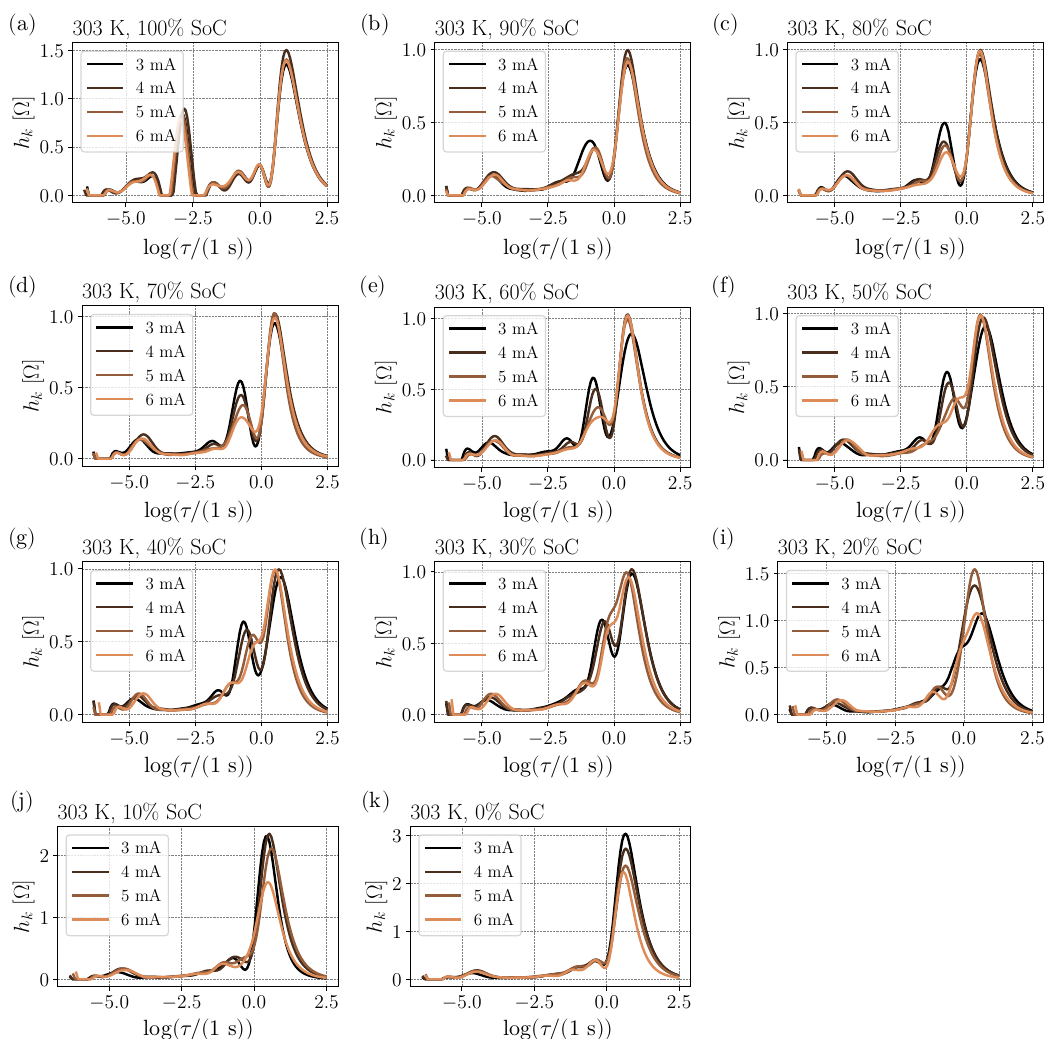
Figure 7. Process analysis of a ZAB at 303 K via the DRT related to different currents and